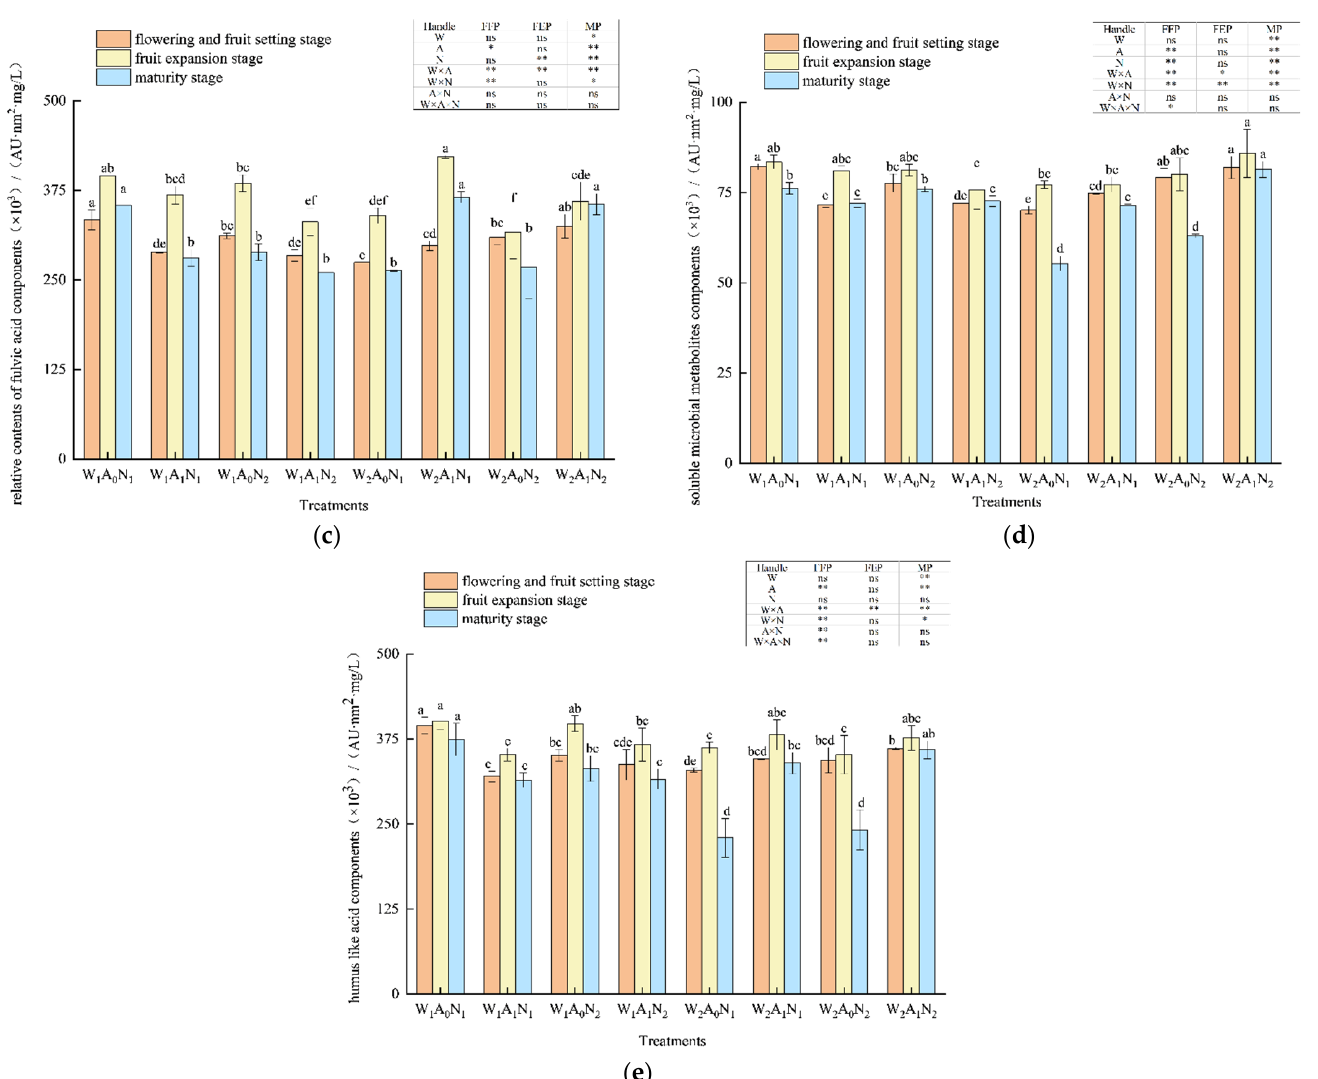
Figure 3. Regional integral analysis of soil DOM based on three-dimensional fluorescence spectra Note: W 1 and W 2 were low and high irrigation water treatment ( 0.6 and 1.0- times crop evaporation pan coefficient), respectively; A 0 and A 1 were non-aeration and aerated irrigation treatments; N 1 and N 2 were low and normal nitrogen application rates (225 and 300 kg hm − 2 ), respectively. * and ** identify significant differences at p < 0.05 and p < 0.01, respectively, and ns identifies no significant difference. ( a ) The amount of irrigation had a significant impact on tyrosine-like proteins at the flowering and fruit-setting stage; ( b ) The tryptophan-like protein components at the flowering and fruit-setting stage, fruit expansion stage, and maturity stage ( c ) The amount of irrigation had a significant impact on fruit-setting stage; ( d ) The tyrosine-like protein components at the soluble microbial metabolites; ( e ) The tyrosine-like protein components at humus acid-like components at the mature stage. Same letters within each column indicate non-significant difference among the